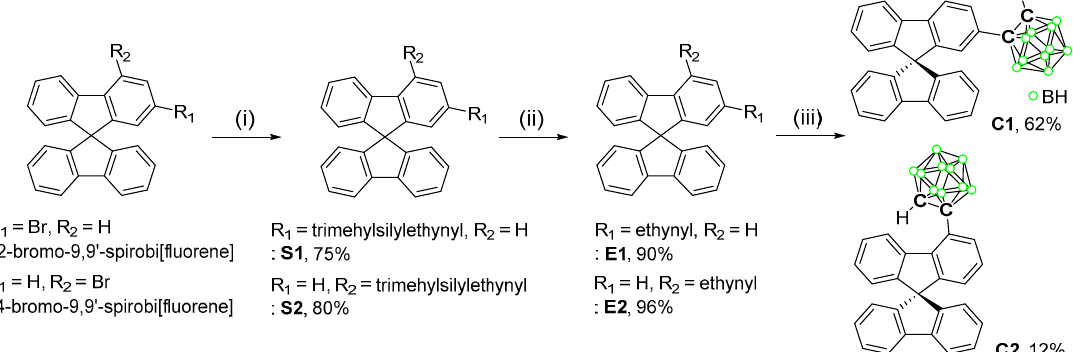
Figure 1. Synthesis routes to the spirobifluorene-based o -carboranyl complexes C1 and C2 . Reaction conditions: (i) Ethynyltrimethylsilane, CuI, Pd(PPh 3 ) 2 Cl 2 , NEt 3 /toluene, r.t., 24 h. (ii) K 2 CO 3 , methanol